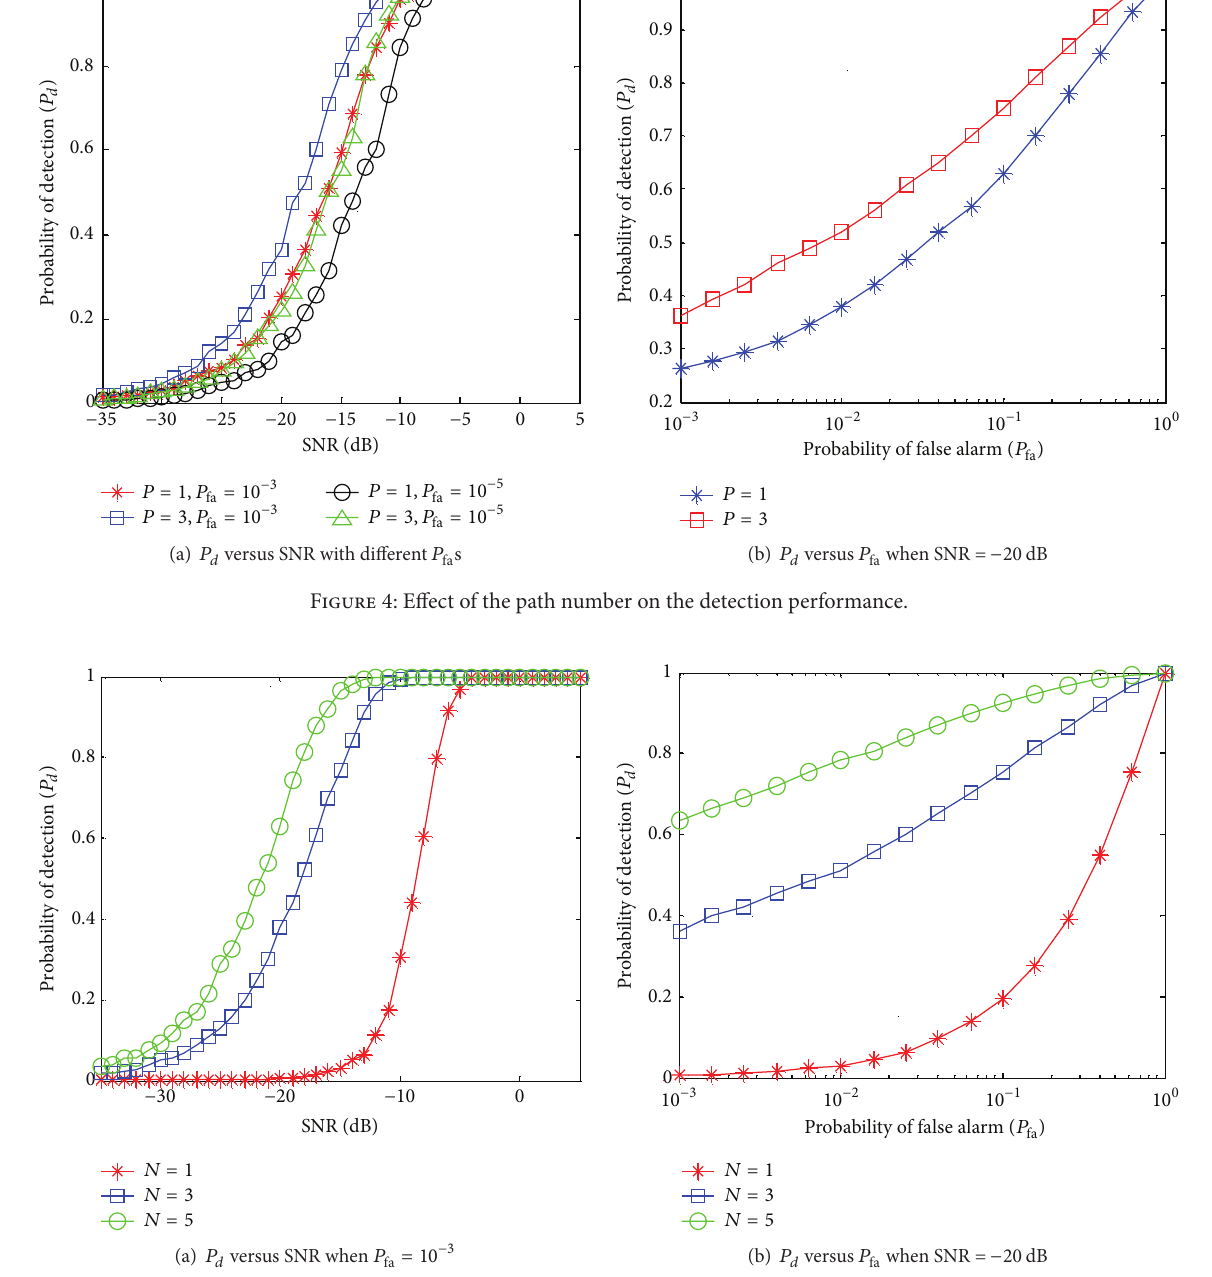
Figure 5: Effect of the subcarrier number on the detection